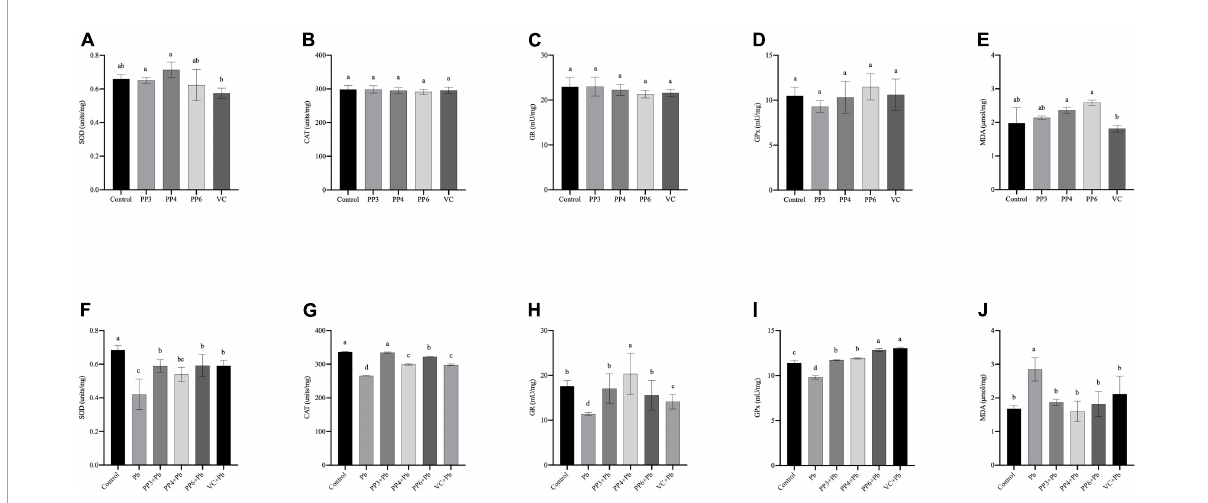
FIGURE3 Effect of PP3, PP4, PP6, and VC on Oxidative stress indicators in PC12 cells. (A–E) PC12 cells incubated with PP3, PP4, PP6, and VC for 4 h. (F–J) PC12 cells were pre-incubated with PP3, PP4, PP6, and VC for 4 h, then treated with lead for 24 h. The results of T-SOD are shown in panels (A,F) . The results of CAT are shown in panels (B,G) . The results of GR are shown in panels (C,H) . The results of GPx are shown in panels (D,I) . The results of MDA are shown in panels (E,J) . The valued of the bars indicates the means ± SD ( n = at least 3). Different superscript letters indicate differences ( P <